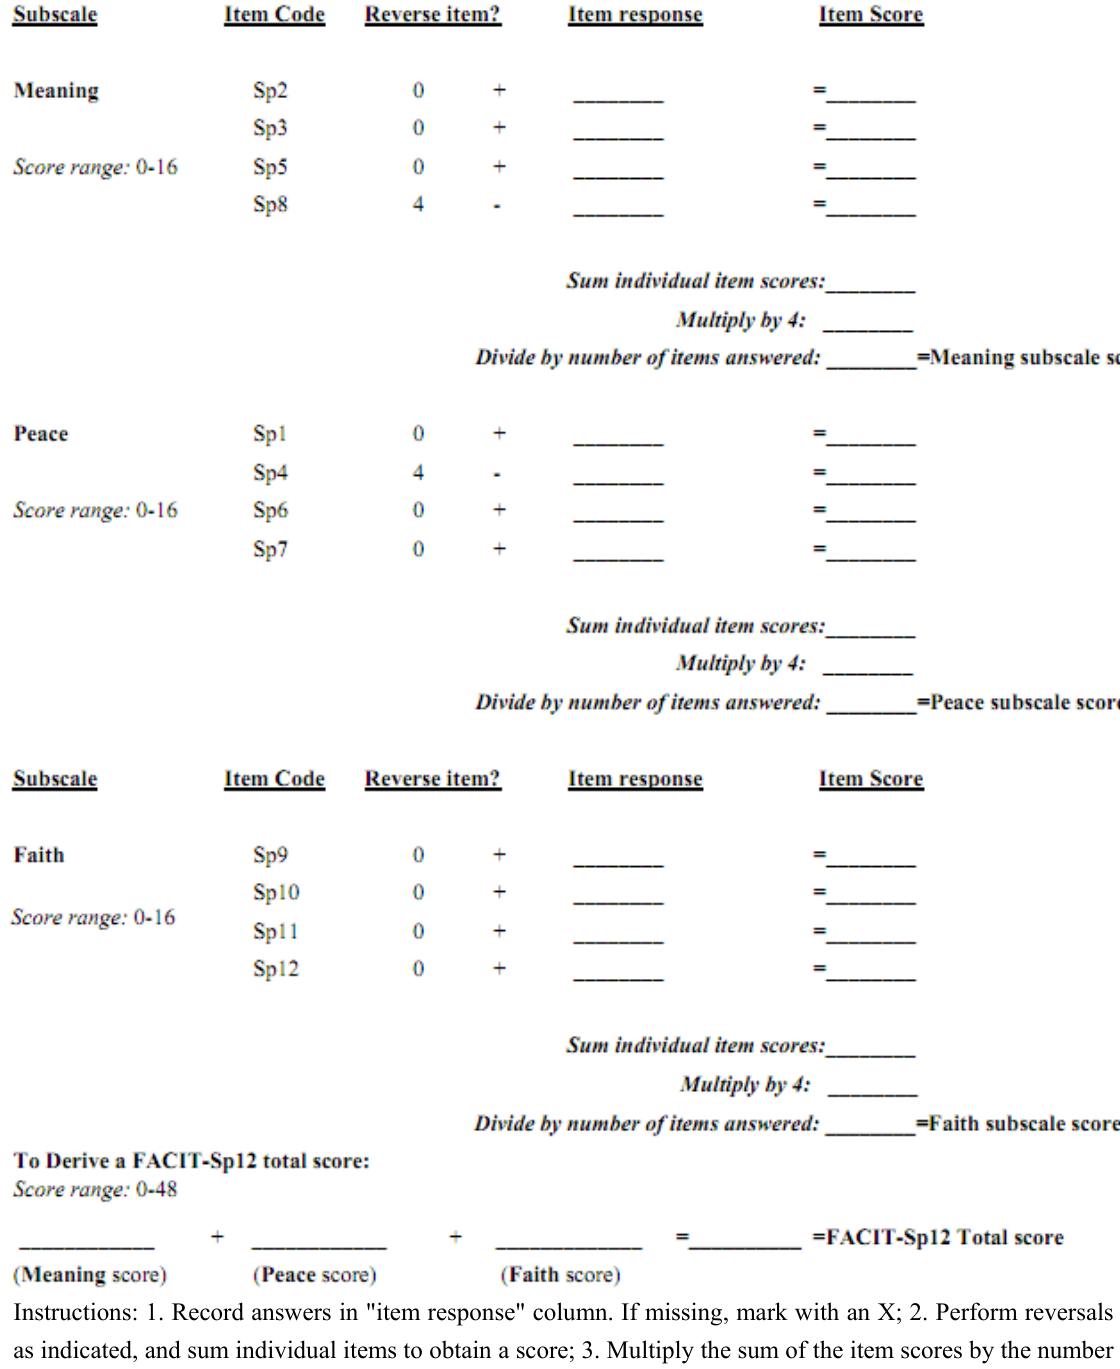
Table 2. FACIT-Sp-12 Scoring Guidelines (Version